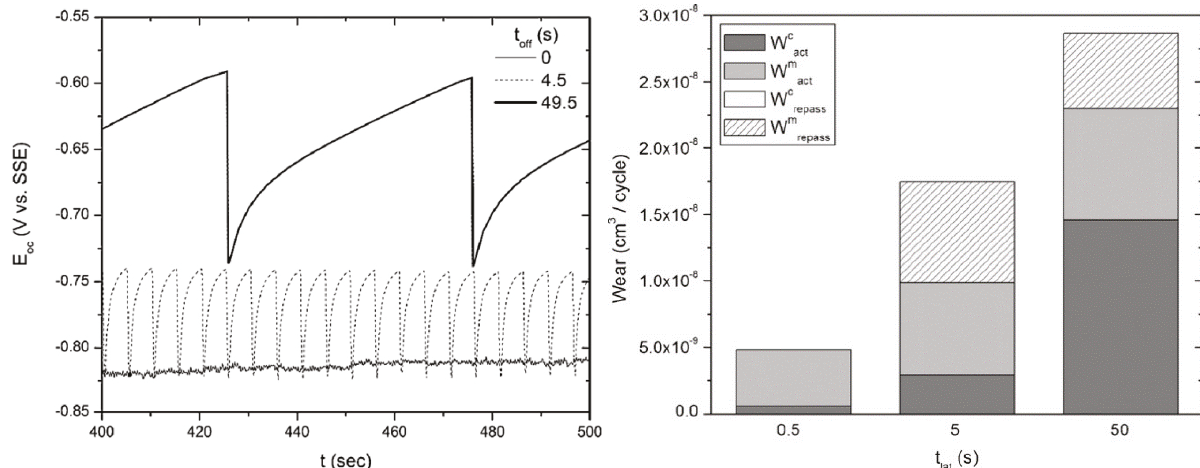
Figure 15: Left: evolution of continuous (t lat =0) and intermittent (t lat =4.5s and t lat =49.5s) potential for an AISI 316 stainless steel in 0.5M H 2 SO 4 at a rotation period (t rot ) of 0.5s. Right: contribution of the tribocorrosion components to the total volumetric material loss at the different latency times